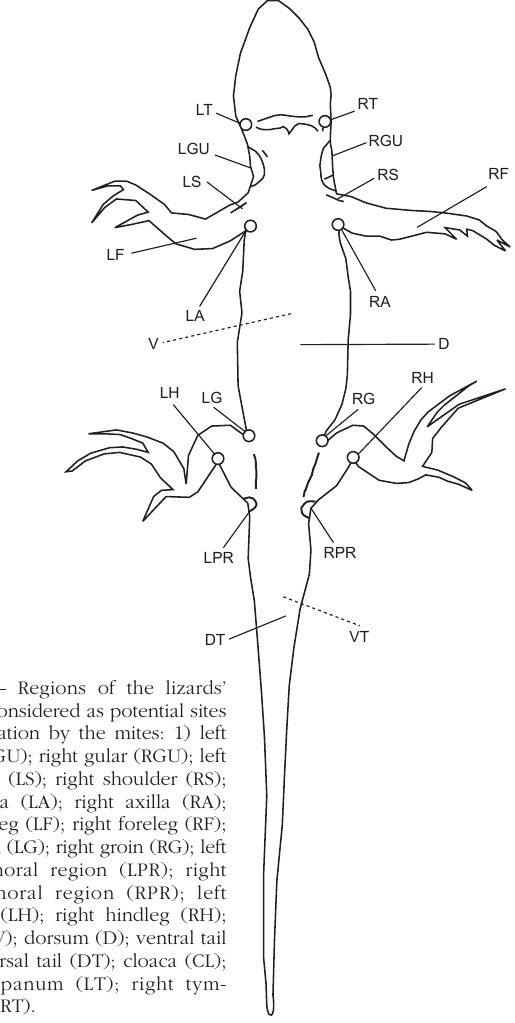
Fig. 1. – Regions of the lizards’ bodies considered as potential sites of infestation by the mites: 1) left gular (LGU); right gular (RGU); left shoulder (LS); right shoulder (RS); left axilla (LA); right axilla (RA); left foreleg (LF); right foreleg (RF); left groin (LG); right groin (RG); left post-femoral region (LPR); right post-femoral region (RPR); left hindleg (LH); right hindleg (RH); venter (V); dorsum (D); ventral tail (VT); dorsal tail (DT); cloaca (CL); left tympanum (LT); right tym- panum (RT).